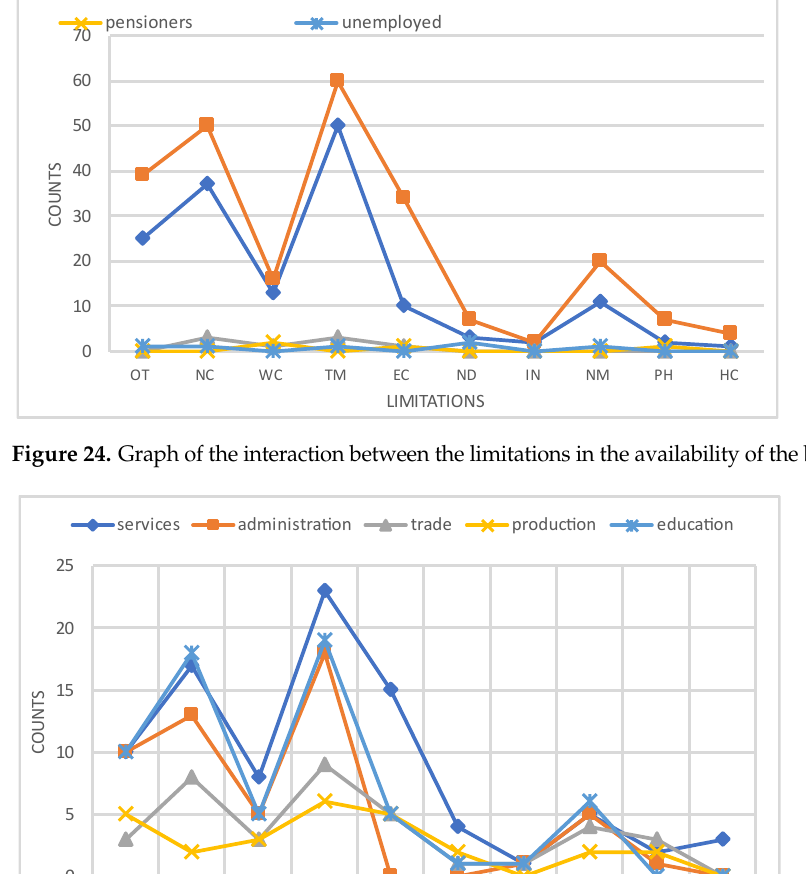
Figure 24. Graph of the interaction between the limitations in the availability of the bus and occu- pation.